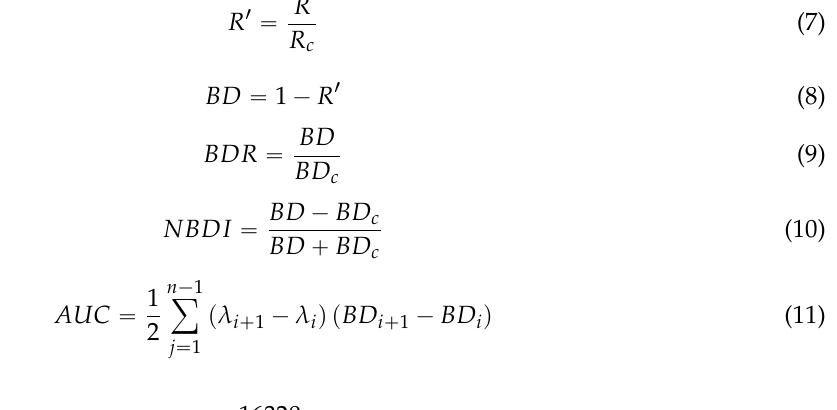
Start, end, and center points of selected spectral regions for continuum removal and subsequent calculation of band depth indices (VIS = visible domain, NIR = near-infrared, SWIR = shortwave infrared). Location of the Selected Wavelength Spectral Domain Start of Spectral Region Center of Spectral End of Spectral Region Analysis (nm) Region Analysis (nm) Analysis (nm) VIS 653 678 724 NIR 1113 1179 1286 SWIR1 1600 1707 1784 SWIR2 2090 2211 2252 Band depth indices including band depth (BD), normalized band depth ratio (BDR), normalized band depth index (NBDI), the area under curve (AUC) of a continuum removed spectrum, as